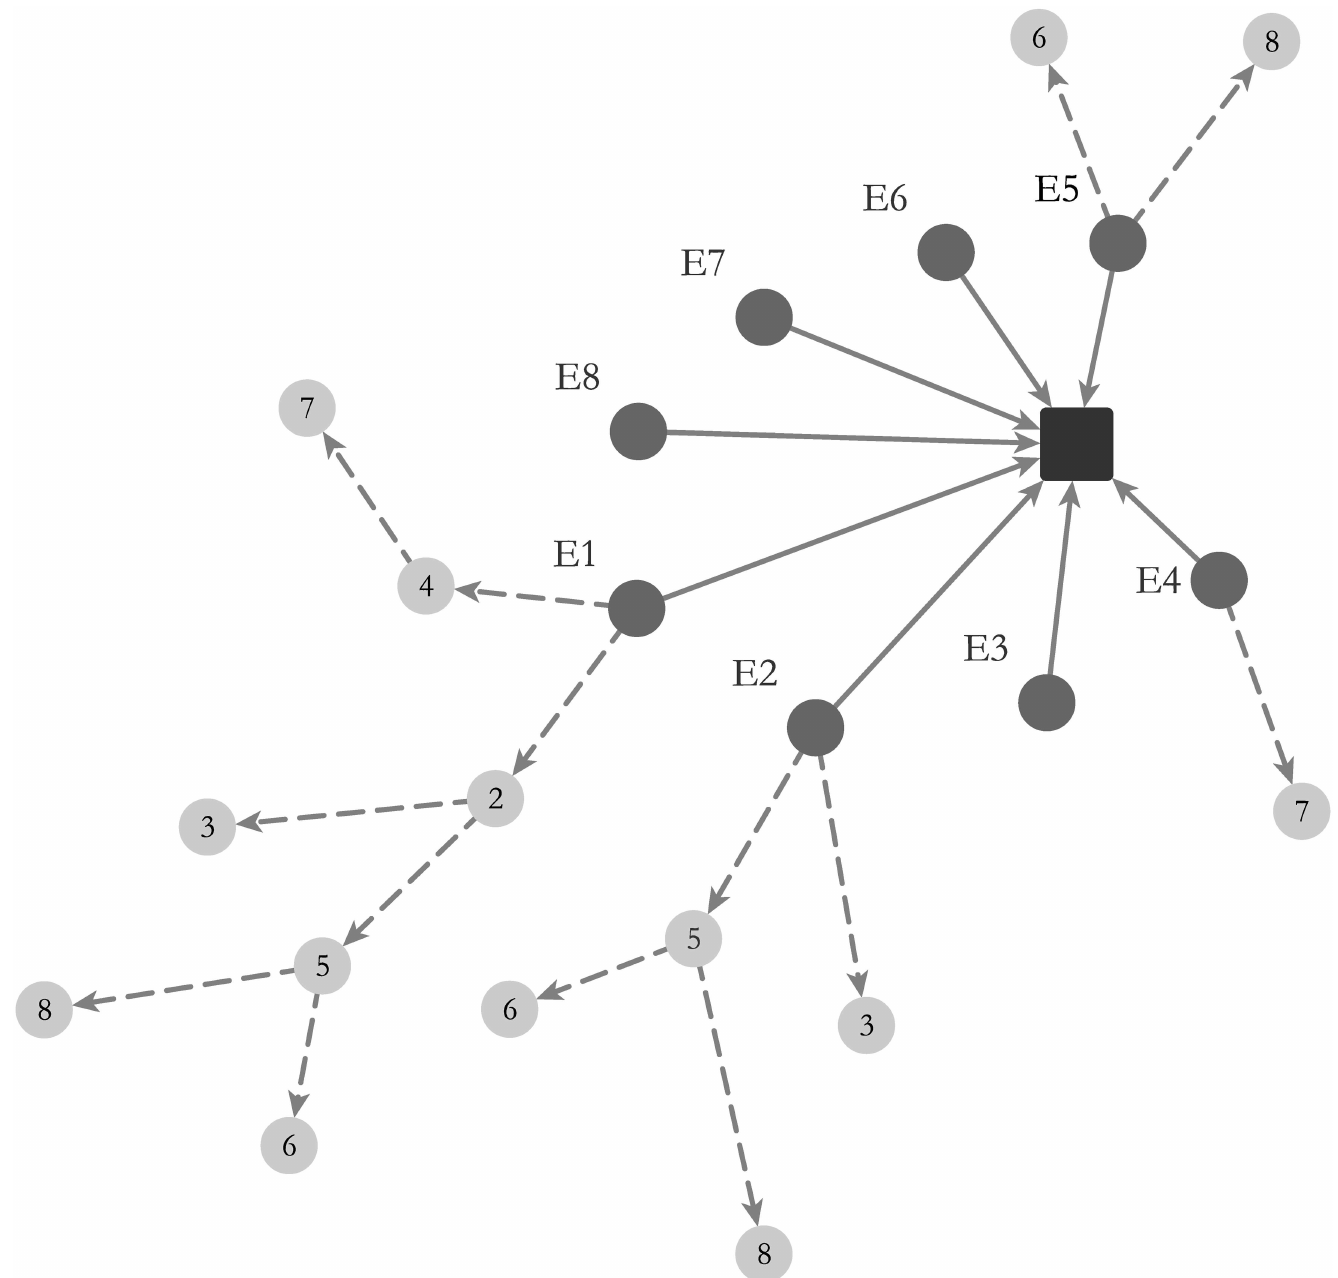
Fig 3. Who-told-whom network for energy